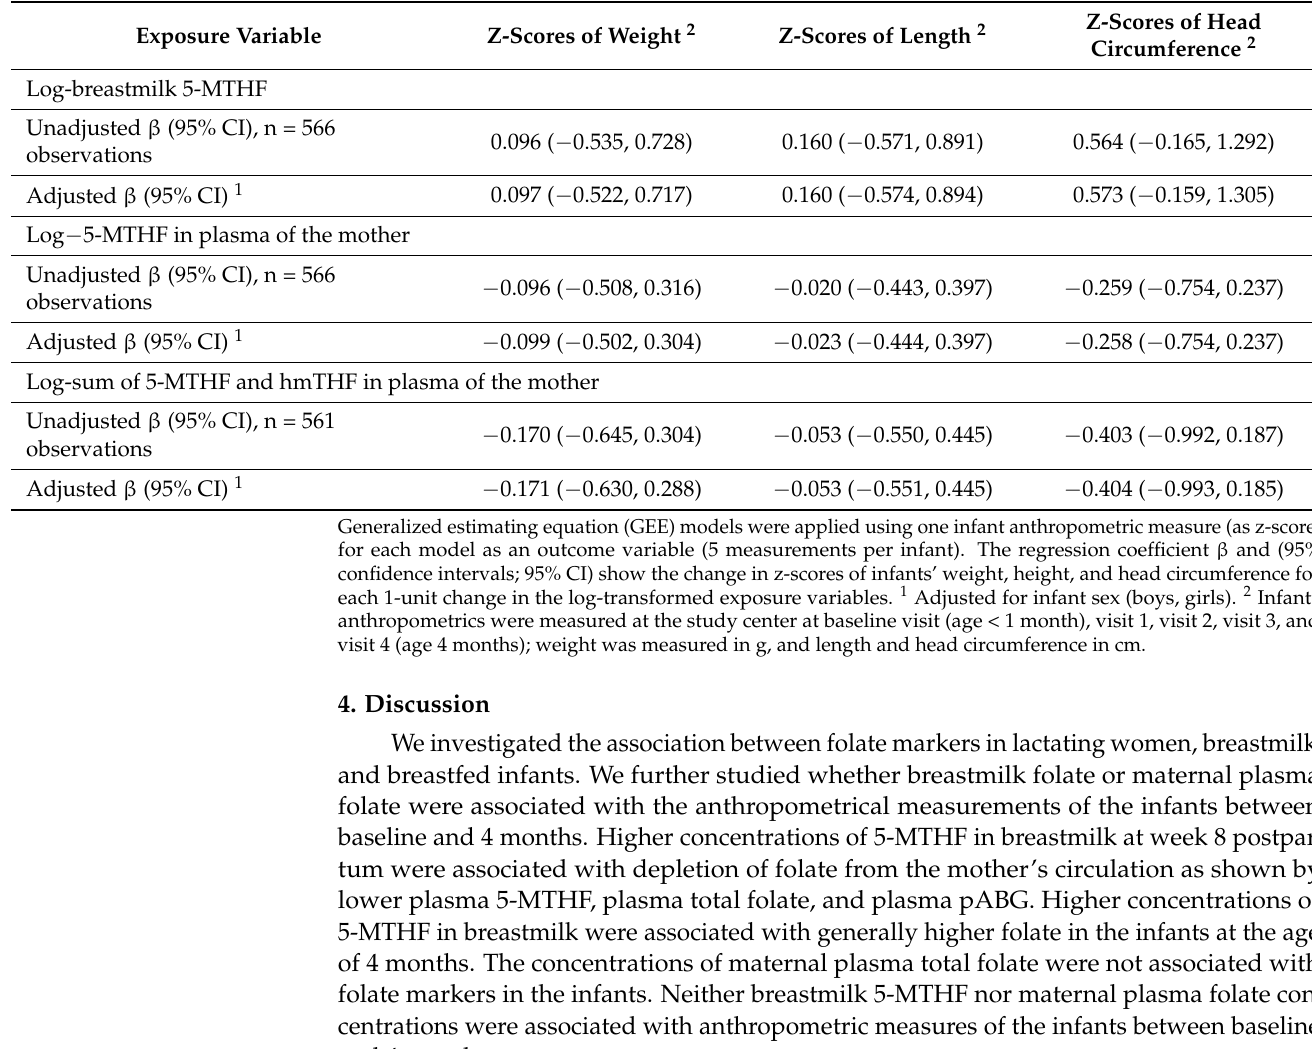
Table 3. The association between breastmilk 5-MTHF or maternal plasma folate at 8 weeks post- partum and the longitudinal changes in z-scores of infant’s weight, length, and head circumference between the age < 1 month and 4